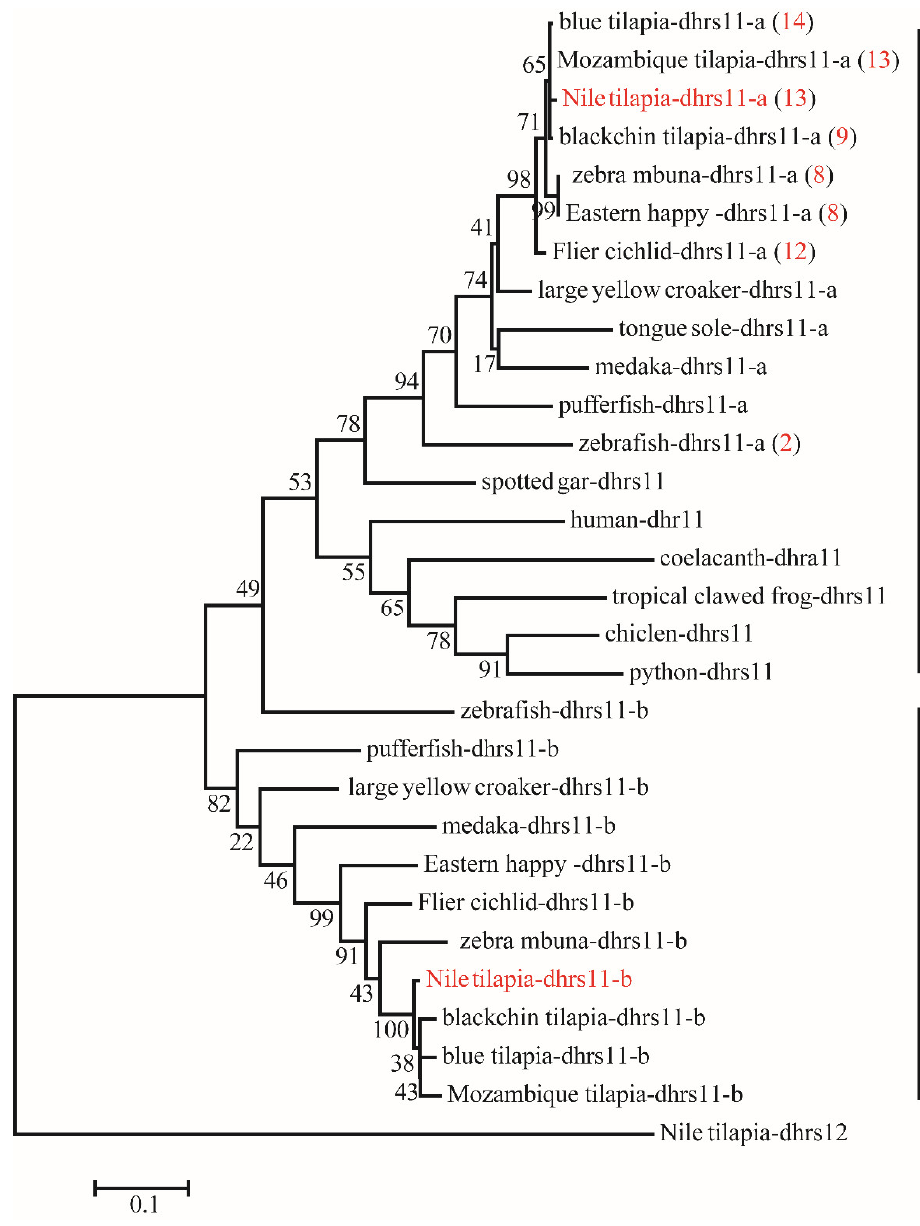
Figure 4. Phylogenetic tree of dhrs11 in vertebrates. The ML tree was constructed using the amino acid sequences from different species using Nile tilapia dhrs12 as the outgroup. All sequences of dhrs11 were clustered into two branches termed dhrs11-a and dhrs11-b . The red numbers in brackets represent the number of tandem duplicates in corresponding species. Numbers at the branch of the phylogenetic tree stand for bootstrap.